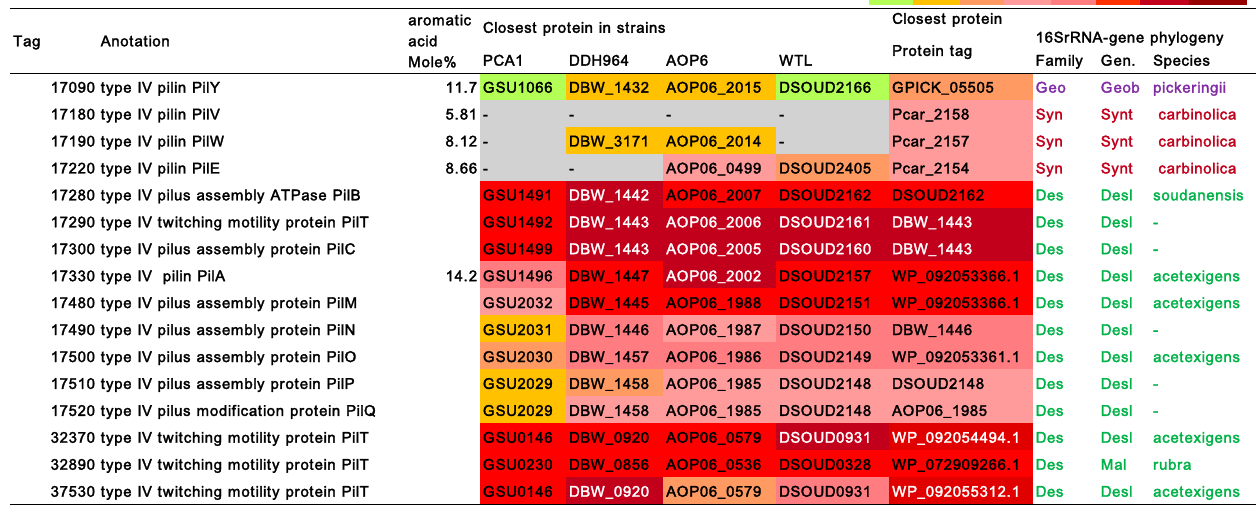
Figure 7. List of T4P assembly-related genes in the NIT-T3 genome Tag indicates the locus tag of coding sequences encoding T4P-related proteins in the genome. The number and color scale for the closest protein in the strain indicates the locus tag and amino acid identity (%), respectively. T4P, Type IV pilli; Geo, Geobacteraceae; Geob, Geobacter; Syn, Syntrophotaleaceae; Synt, Syntrophotalea; Des, Desulfuromonadaceae; Desl, Desulfuromonas; Mal, Malonomonas.